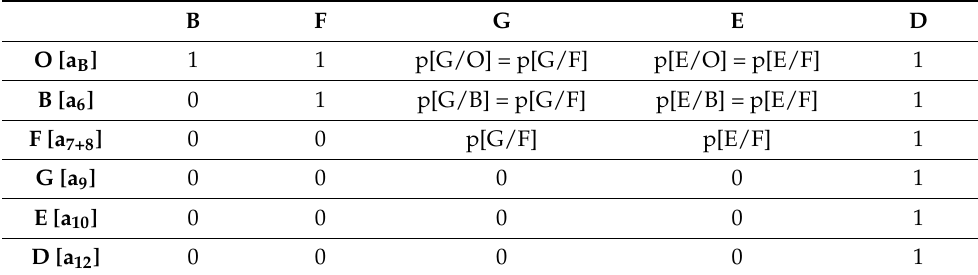
Table 2. Example of transition probability matrix of the state–action tree in Figure 2b. B